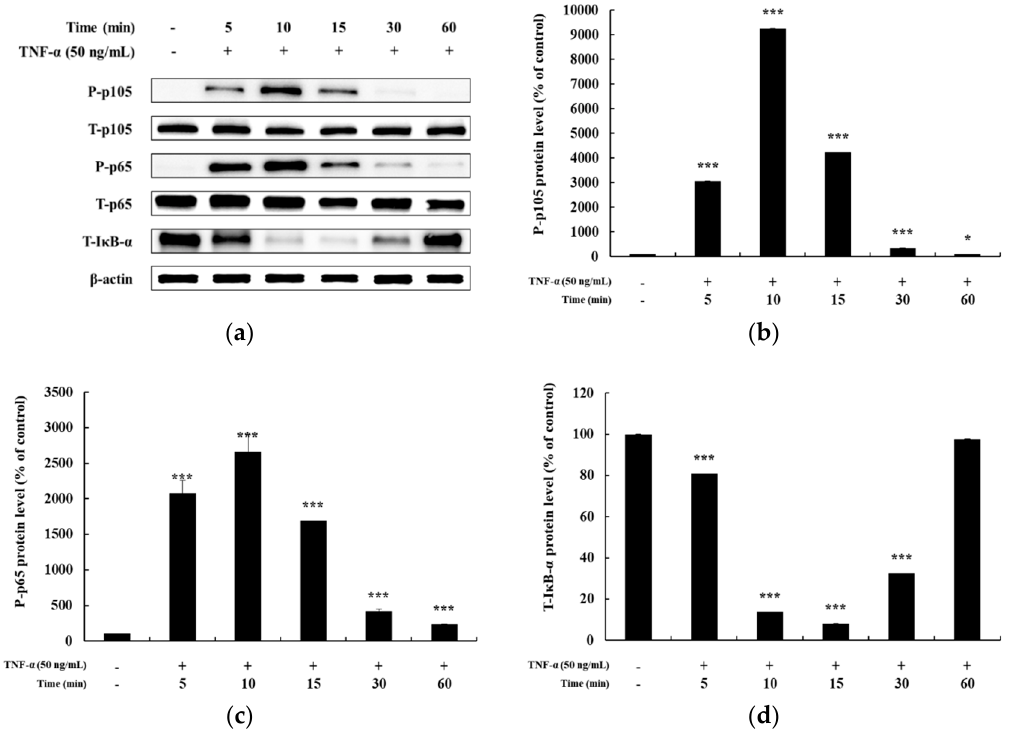
Figure 4. Effect of TNF- α on NF- κ B pathway in HaCaT cells. Cells were treated with TNF- α (50 ng/mL) for 5, 10, 15, 30, and 60 min, and cell lysates were prepared for western blot analysis. Data are presented as the mean ± SD (n = 3). * p < 0.05, *** p < 0.001 vs. control.